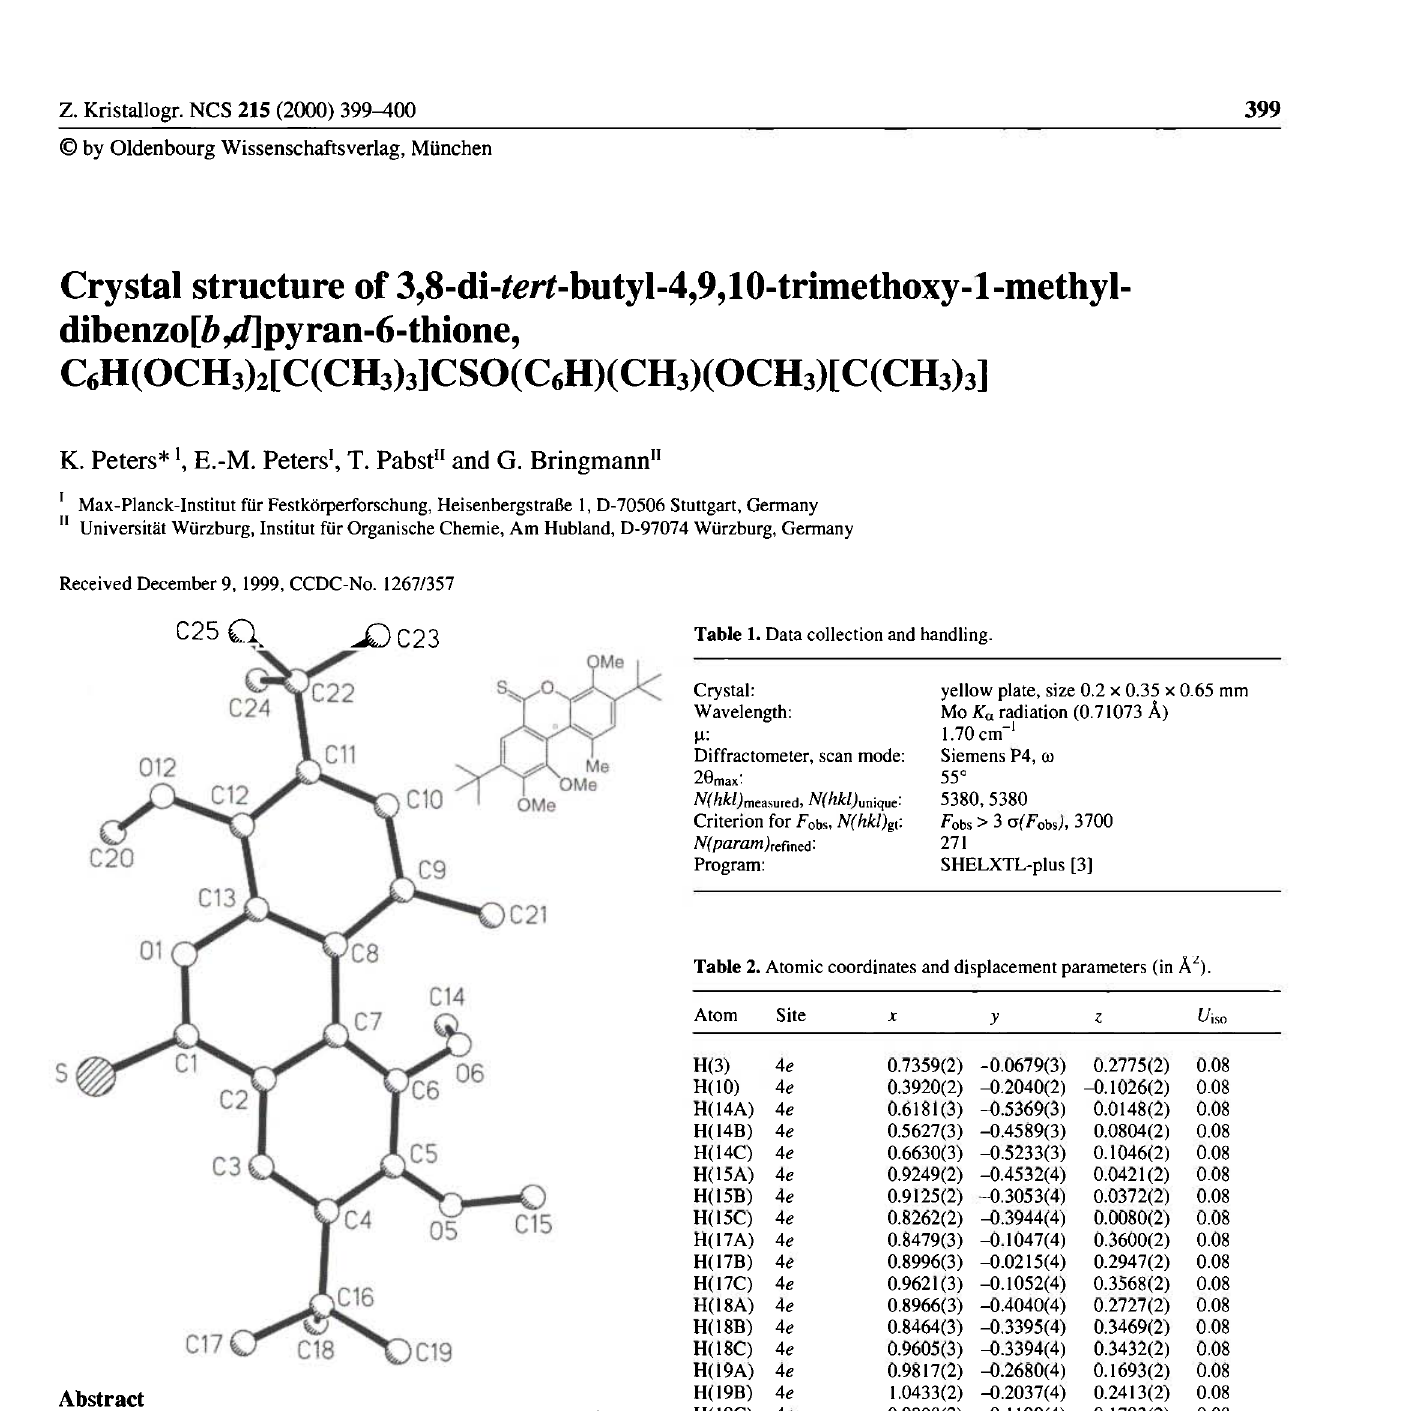
Table 2. Atomic coordinates and displacement parameters (in Ä